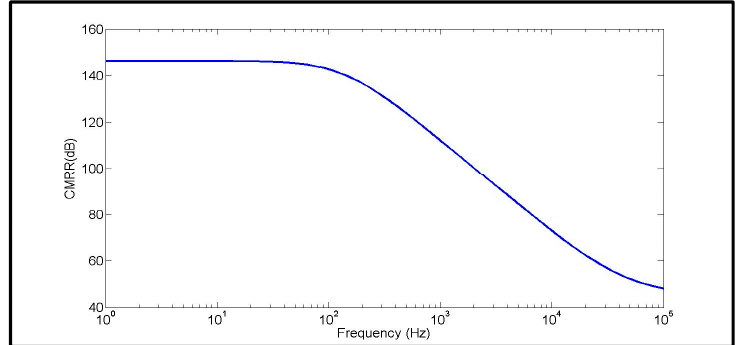
Figure 11. The common mode rejection ratio (CMRR).